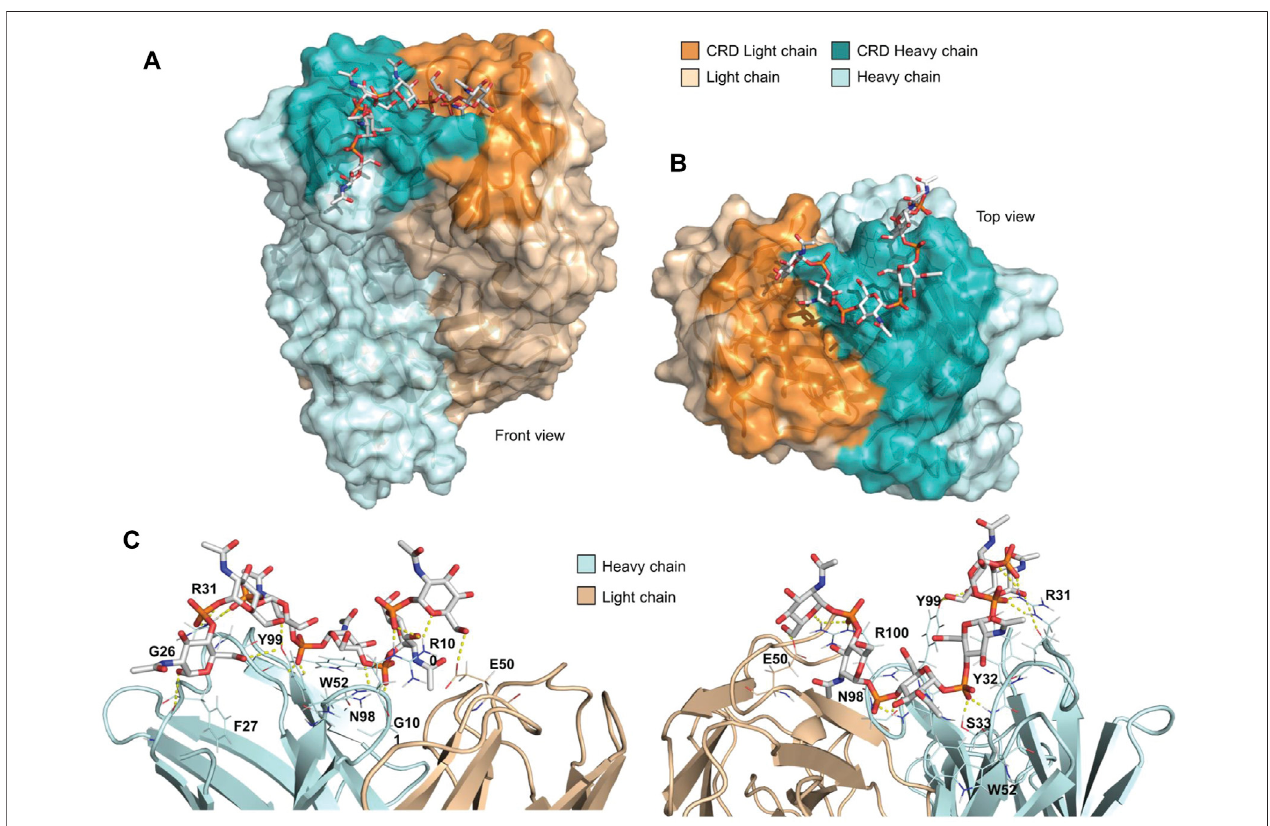
FIGURE 5 | Docking of DP6 with MenX.01 Fab. (A) Top and (B) side view of the docking pose. DP6 engages the mAb binding pocket from the heavy to the light chainsintheCRD. (C) Detailedintermolecularinteractionsinthedocked-minimizedstructureofthecomplexbetweenMenX.01FabandMenXDP6OS.Theaminoacids that contribute to the binding are